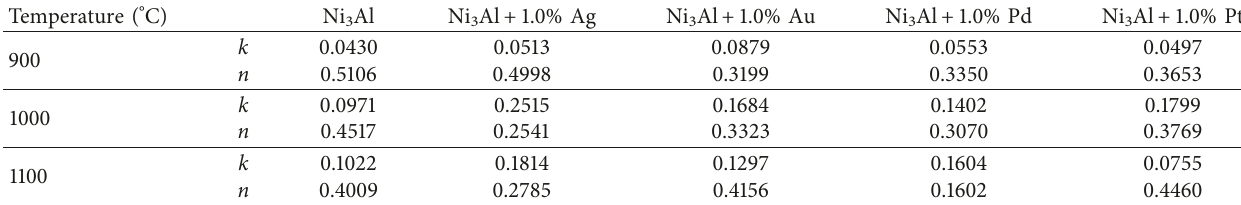
Figure 4: Weight gain of intermetallic alloys oxidized in O Table 2: Values of k and n obtained from the curves of weight gain.